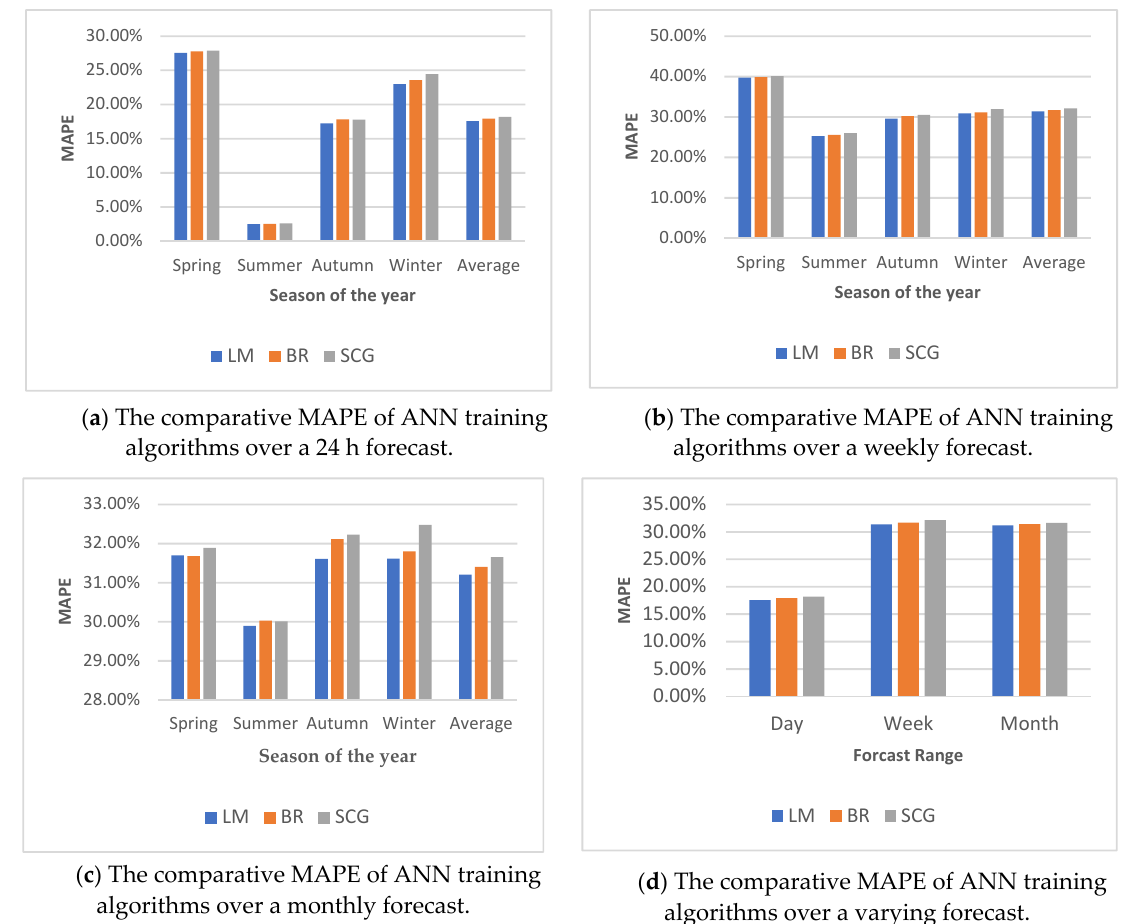
Figure 2. The comparative MAPE of ANN training algorithms.